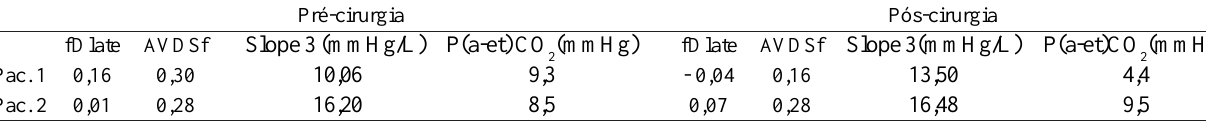
Tabela 1. Valores dos gradientes e variáveis capnográficas pré e pós-cirurgia